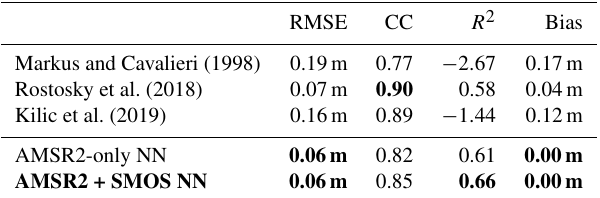
Table 2. RMSE, correlation, coefficient of determination, and bias between the different snow depth retrieval algorithms and OIB- measured snow depth for all the test data. When no SMOS data are available, the neural network with SMOS is equal to the neural net- work without SMOS. The best score of each category is highlighted in bold. RMSE CC R 2 Figure 4. OIB-measured snow depth (test data) versus estimated snow depth using different algorithms. Note that Markus and Cav- alieri (1998) should only be applied over FYI, but this plot also includes